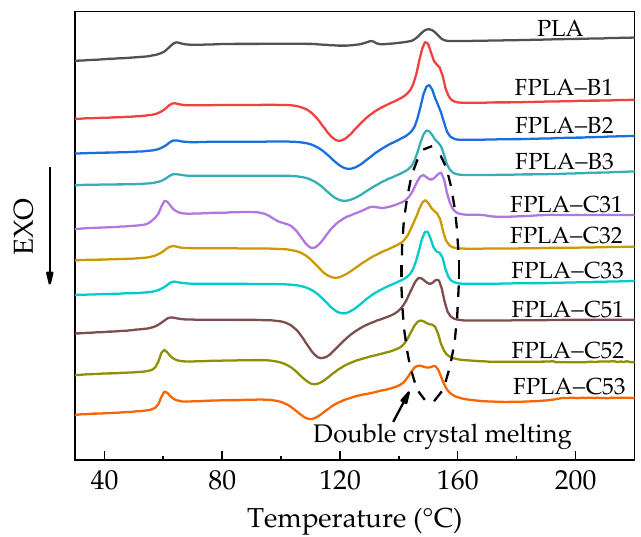
Figure 5. Heat flow curves of PLA and its blends.